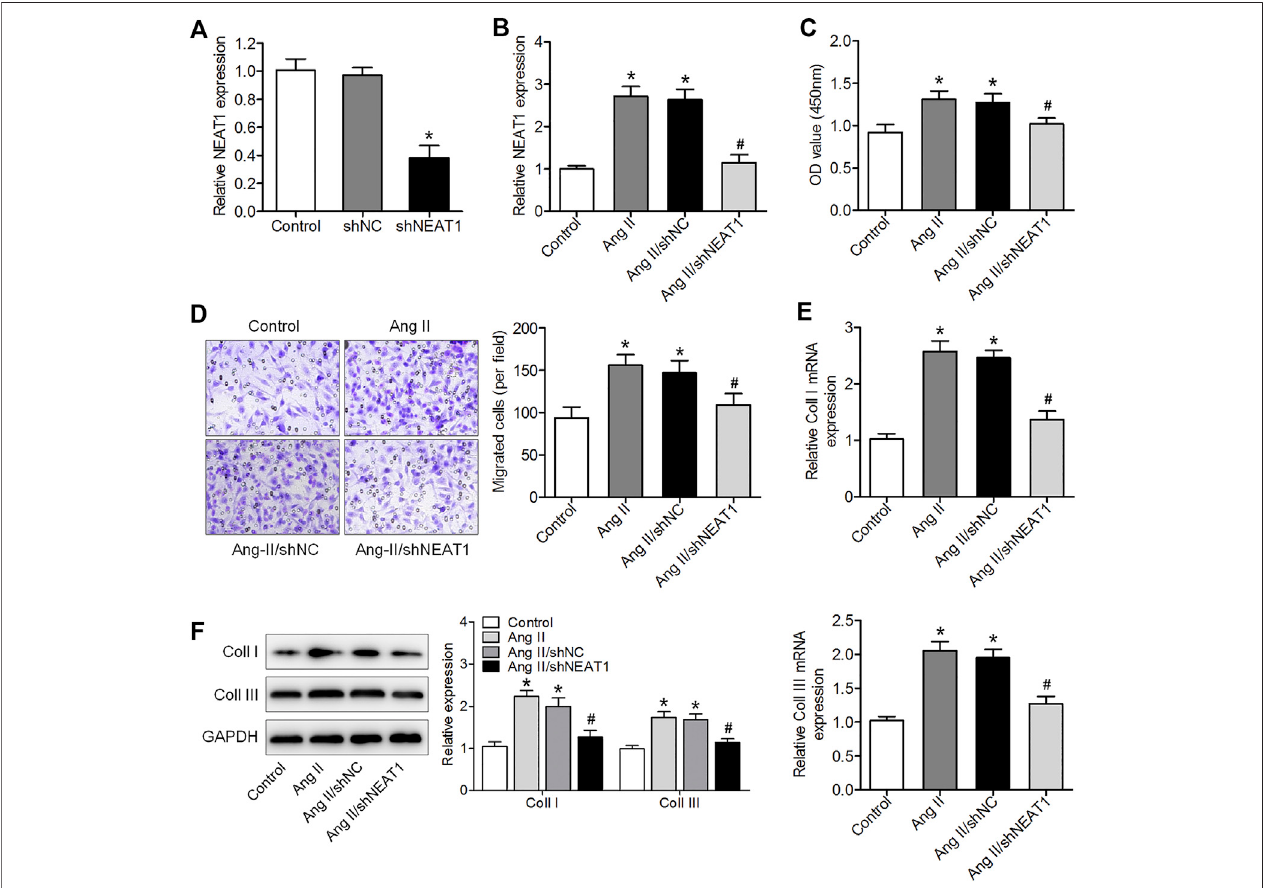
FIGURE 2 | NEAT1 downregulation suppressed Ang II-induced cardiac fi broblast proliferation, migration, and collagen production. (A) NEAT1 expression in shNEAT1-or shNC-transfected cardiac fi broblasts was detected using qRT – PCR. (B) NEAT1 expression was detected in Ang II-treated cardiac fi broblasts using qRT – PCR. (C) Cell proliferation and (D) migration were determined using CCK-8 and Transwell assays (E,F) mRNA and protein expressions of coll I and coll III were measured using qRT – PCR and western blotting. * p < 0.05 vs. control group; # p < 0.05 vs. Ang II/shNC group. Data represent mean ± SD from three independent